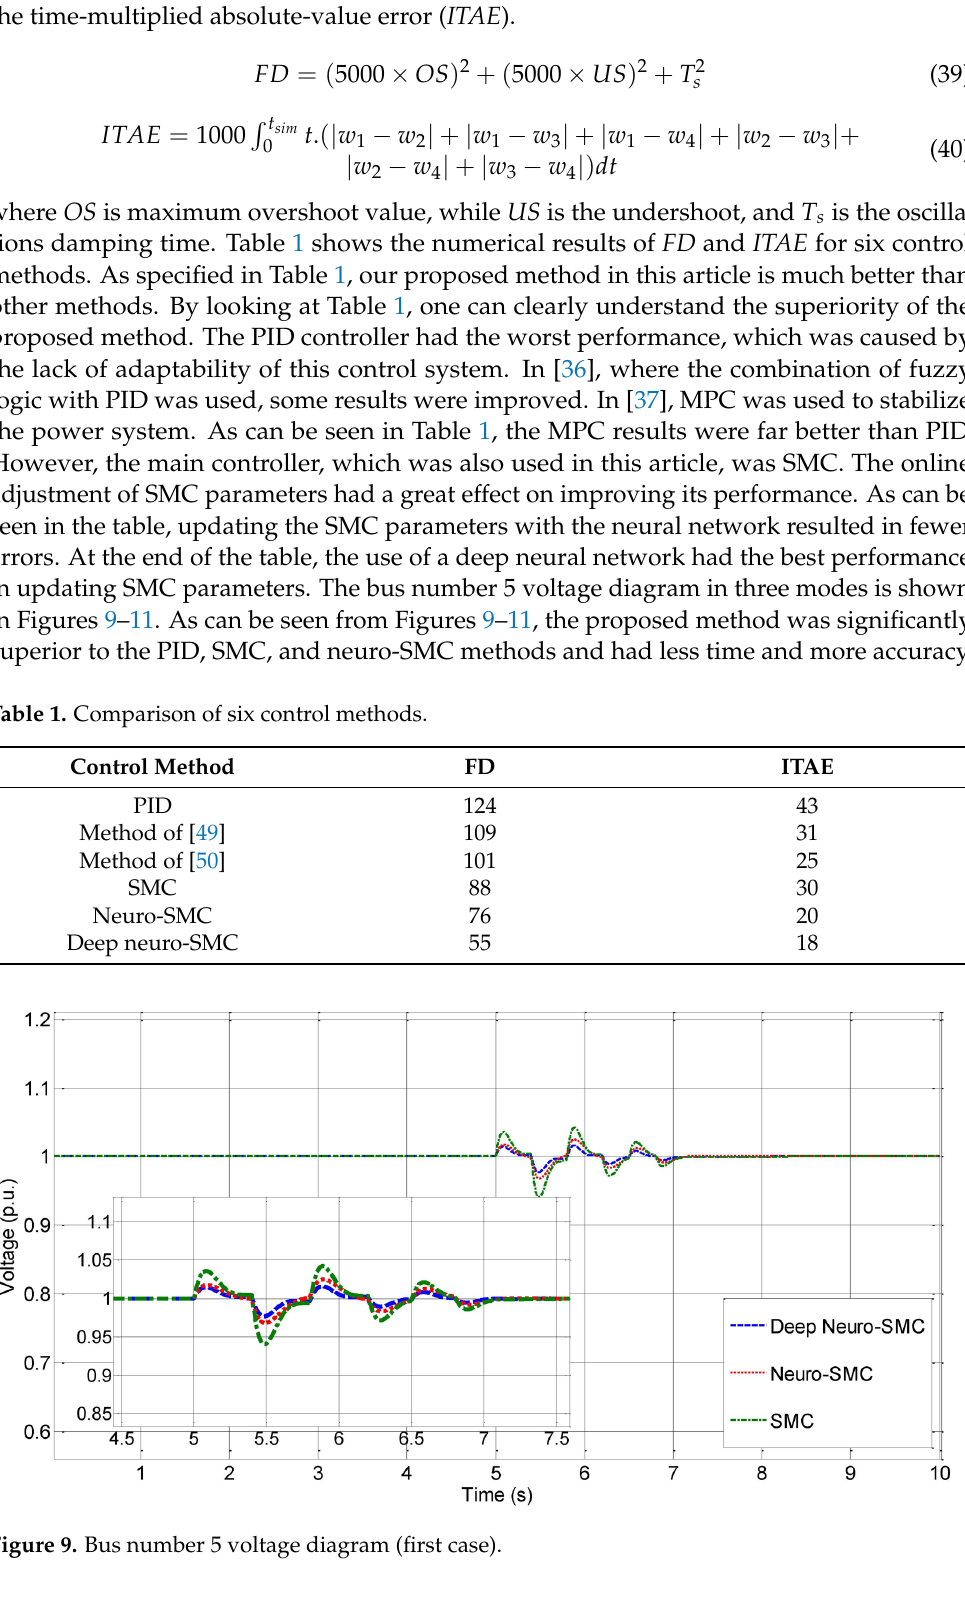
Figure 10. Bus number 5 voltage diagram (second case).